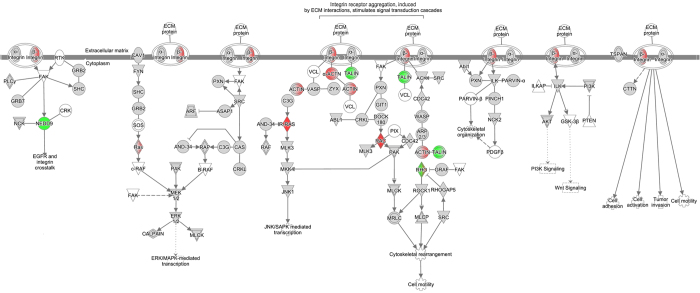
Integrin signaling pathway, upregulated by L. plantarum TIFN 101 compared to placebo.Green and red coloured genes indicate down or upregulation, respectively. Grey indicates the regulation did not reach significance.